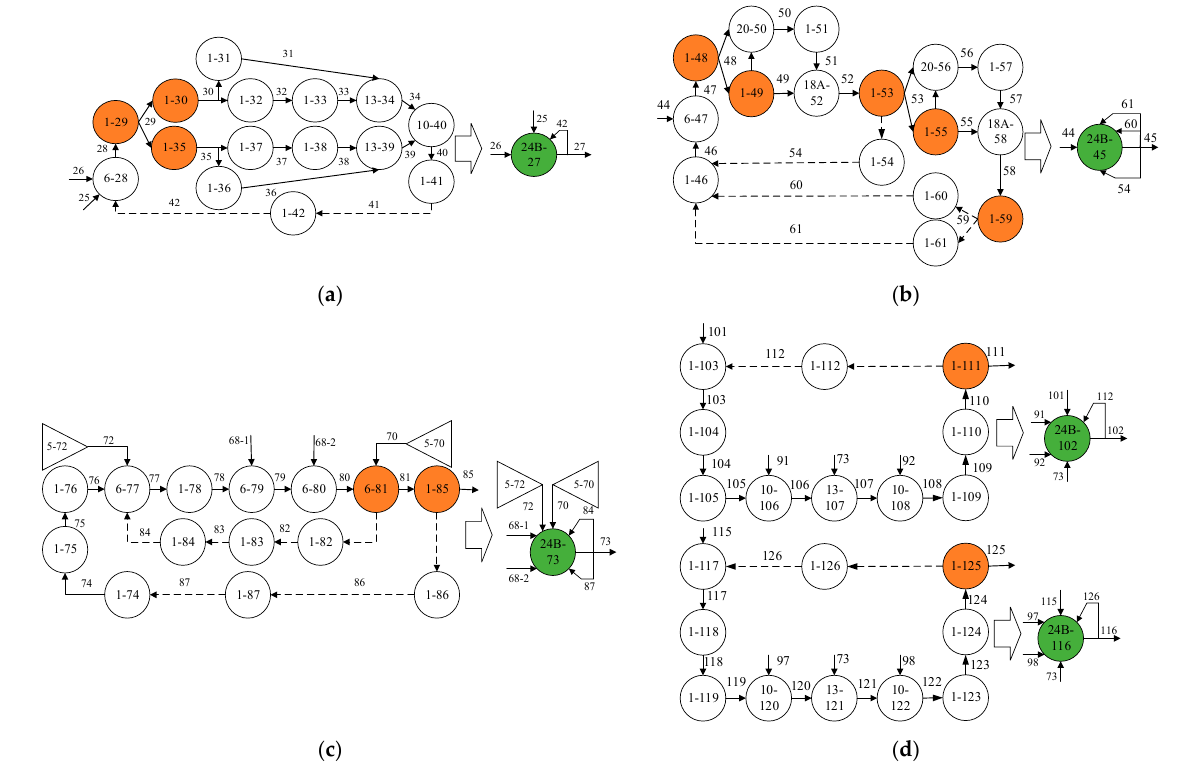
Figure 3. The first-level GO diagram model of the diesel engine system. ( a ) First-level GO diagram model of the cooling system; ( b ) First-level GO diagram model of the lubrication system; ( c ) First-level GO diagram model of the fuel supply system; and ( d ) First-level GO diagram model of the inlet, exhaust, and turbocharge system. (2) The GO model of the diesel engine system With the system analysis and Table 1, the first-level GO diagram model is integrated into the second-level GO diagram model to form the GO diagram of the diesel engine system, as illuminated in Figure 4. The first digit of the operator represents its number, and the second digit represents its type. The digit on the signal flow indicates its number. Signal flows 23, 27, 45, 128, and 129 are the power, cooling, lubrication, and exhaust func- tions of the diesel engine, and the output signal flows of the system, respectively.